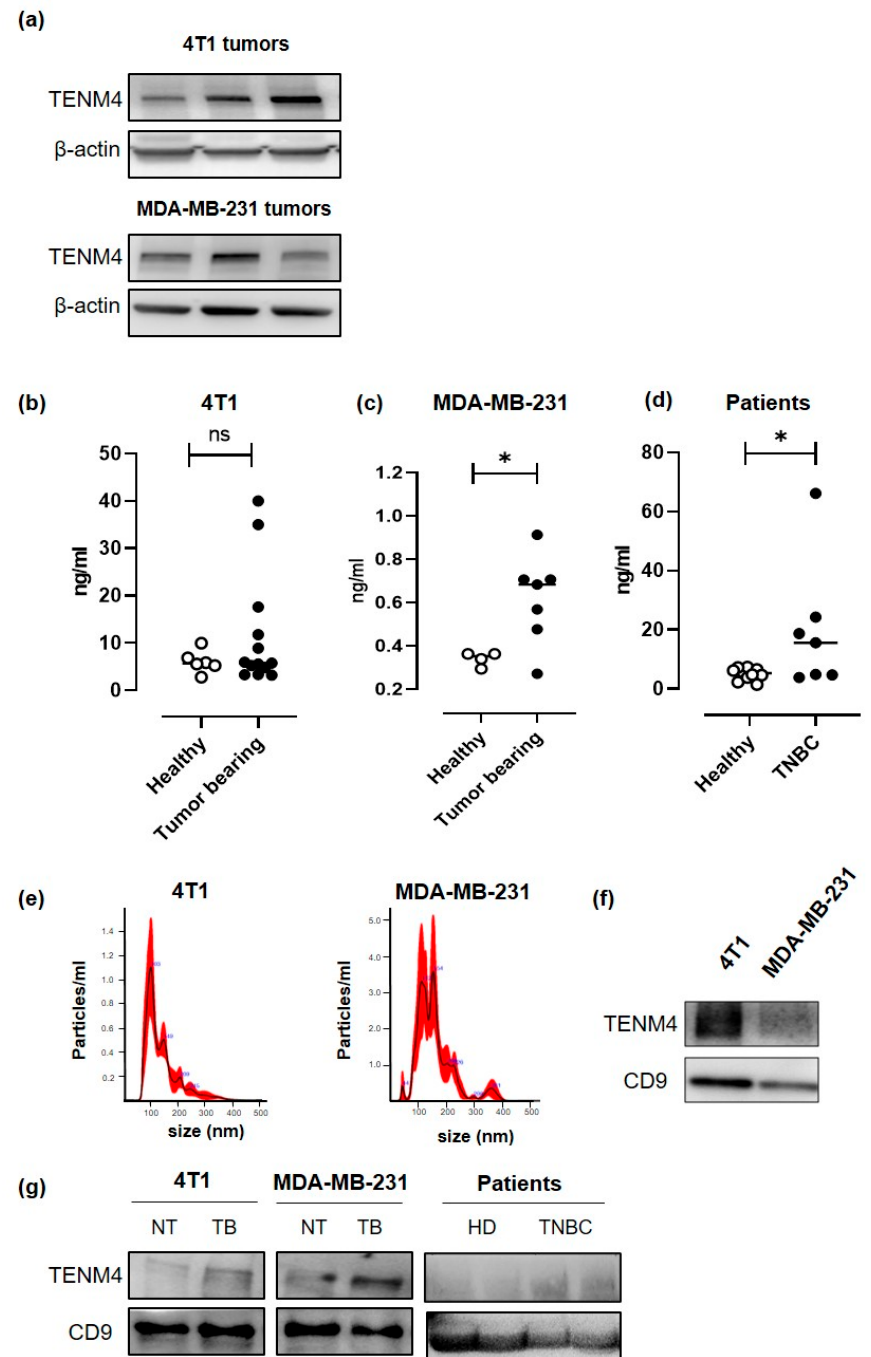
Figure 5. Evaluation of the role of TENM4 as TNBC biomarker. ( a ) Representative immunoblot of TENM4 and loading control protein, β -actin, in tumors derived from the subcutaneous injection of 4T1 (upper panel) or MDA-MB-231 (lower panel) cells. ( b ) ELISA assay revealing the presence of TENM4 protein in the plasma of tumor-bearing mice injected with 4T1 (left panel; n = 13), ( c ) MDA-MB-231 (central panel; n = 7) cells or ( d ) in TNBC patients (right panel; n = 7) comparing to healthy subjects (Healthy; n = 13; n = 7; n = 10, respectively). ( e ) Representative graphs of nanoparticle tracking analysis and ( f ) representative immunoblot of TENM4 and CD9 of extracellular vesicles (EVs) collected from 4T1 and MDA-MB-231 conditioned media. ( g ) Representative immunoblot of TENM4, CD9 and CD63 assessing their expression in plasma-derived EVs collected from 4T1-, MDA-MB-231-derived tumor-bearing (TB) or not treated (NT) mice or from TNBC patients compared to healthy donors (HD). Statistical analysis was carried out with Student’s t -test: * p <